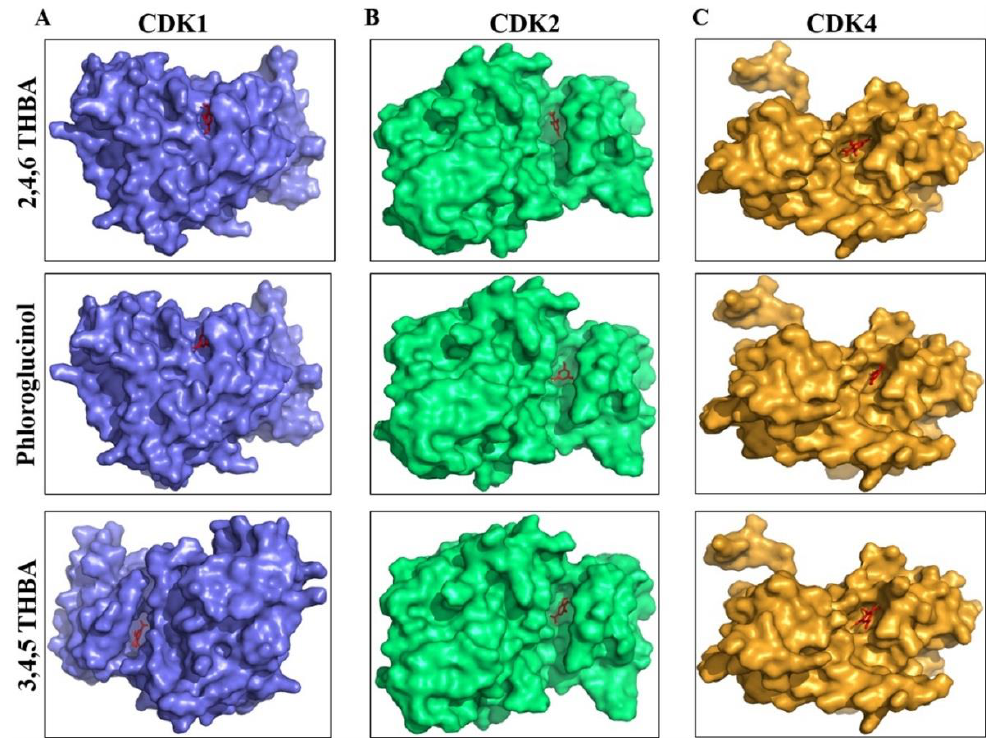
Figure 4. Space-filling model showing the orientation of the compounds and the potential binding pockets in CDK1 ( A ), CDK2 ( B ) and CDK4 ( C ) for 2,4,6-THBA (upper panel), phloroglucinol (middle panel) and 3,4,5-THBA (lower panel).